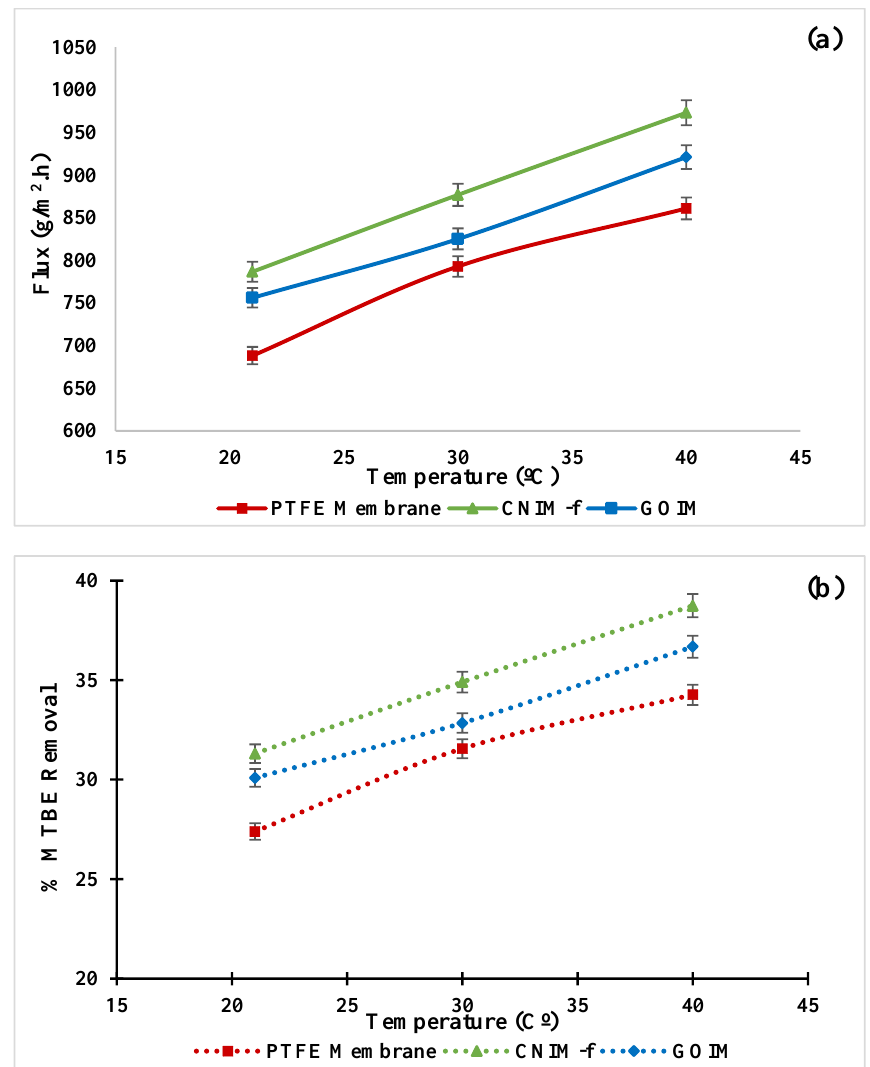
Figure 8. ( a ) Effect of feed temperature on MTBE flux, and ( b ) % MTBE removal as the function of feed temperature at the feed concentration of 1.5 wt% and the feed flow rate of 20 mL/min.